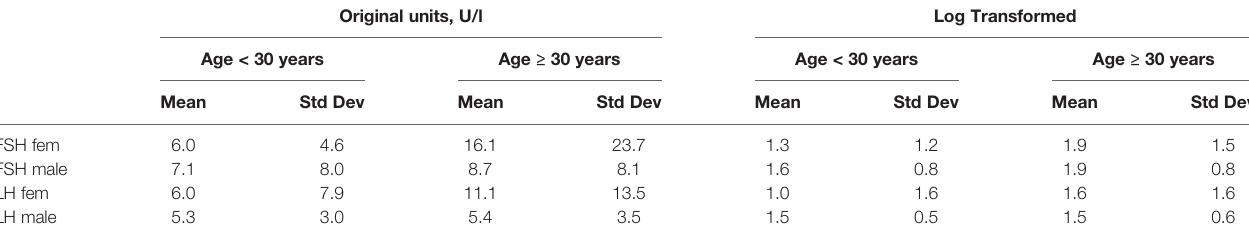
TABLE 2A | Hormone statistics in HD14 according to age group; Standard deviation (Std